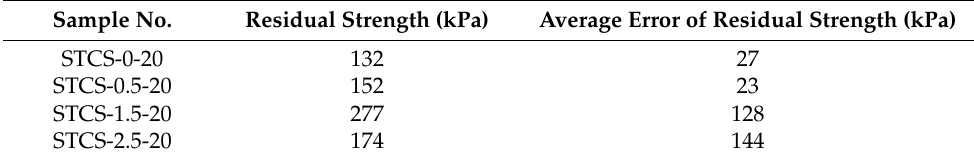
Table 8. Residual strength of each group of STCS.